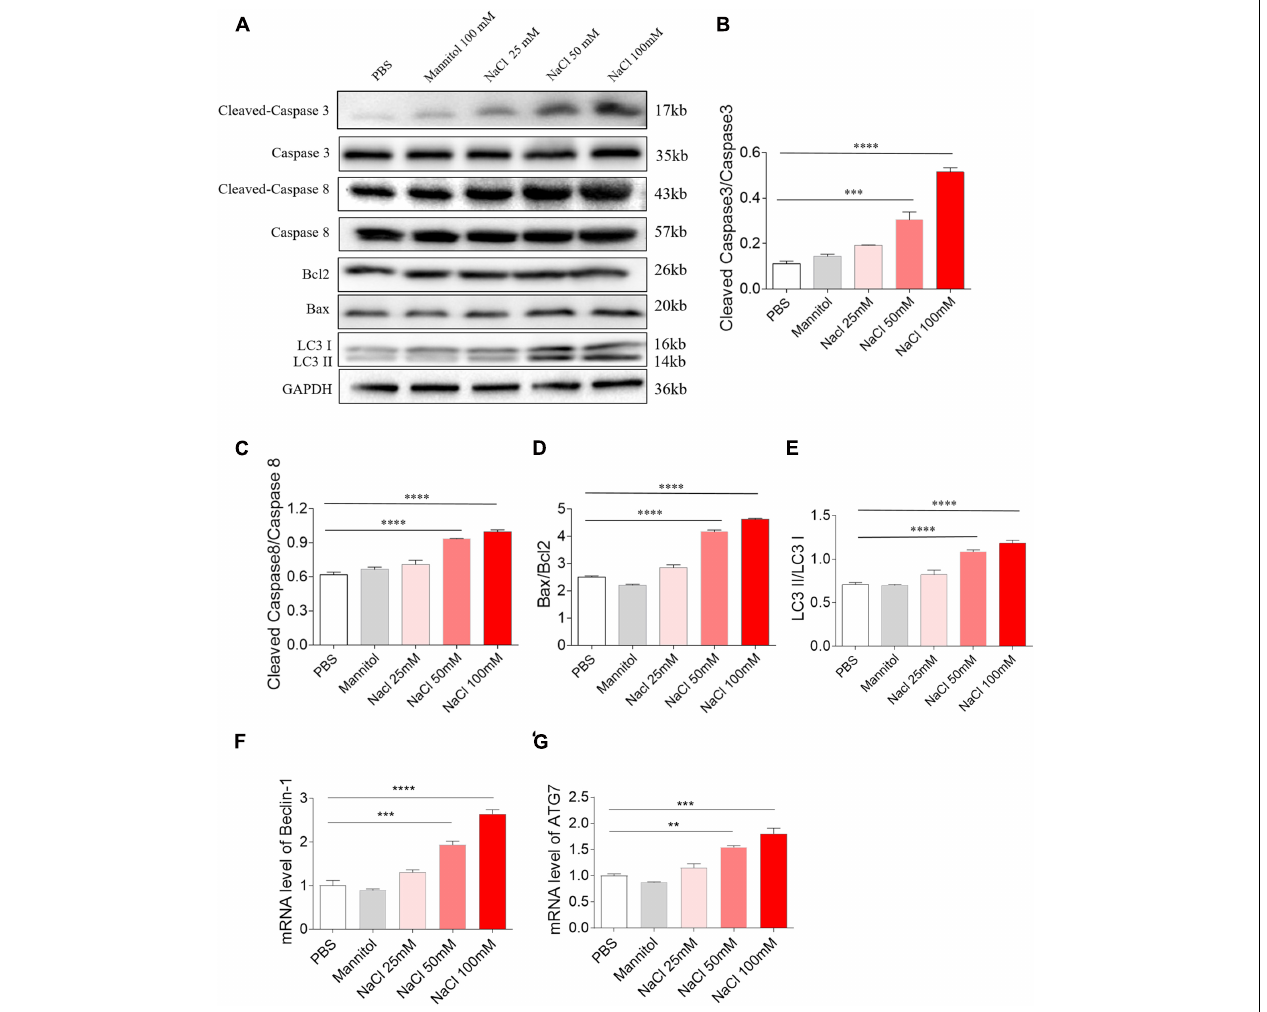
FIGURE 3 | Effects of different doses of sodium chloride (NaCl) on apoptosis and autophagy in H9C2 cells. Middle (50 mM) and high (100 mM) doses of NaCl increased the levels of cleaved-caspase 3/caspase 3 (A,B) , cleaved-caspase 8/caspase 8 (A,C) , Bax/Bcl2 (A,D) , LC3 II/LC3 I (A,E) , Beclin-1 (F) , and autophagy related 7 (ATG7) (G) in H9C2 cells. The results are expressed as mean ± SEM; n = 6 in each group. ** p < 0.01, *** p < 0.001, and **** p <